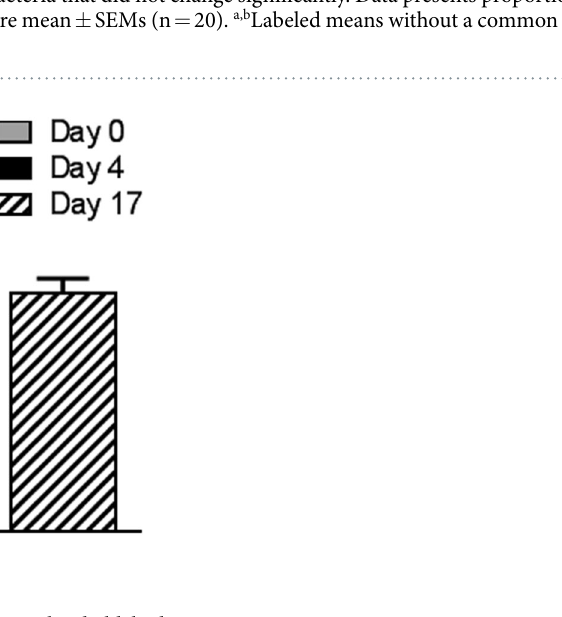
decrease in body weight (p = 2.0E − 05 ). The observed weight loss remained significant and persisted over the fol- lowing 2 weeks and may be related to changes in the microbiome (p = 0.003). The two most abundant bacterial phyla in humans are Firmicutes (40–60%) and Bacteroidetes (20–40%) 10 . Relative proportional abundance of Firmicutes has been associated with increased body weight and that of Bacteroidetes with low body weight. The 3-day juice based diet of only drinking 6 bottles of fruit/vegetable juice blends induced significant changes in the intestinal microbiota. The proportional abundance of the phylum Firmicutes was significantly decreased, while Bacteroidetes was significantly increased when comparing end of juice based diet (day 4) to baseline (Table 1). Human Bacteroides species are able to degrade diverse plant fiber and complex polysaccharides, including pectin and xylans from fruit and vegetable 16, 17 . Bacteroides ovatus, B. thetaio- taomicron and B. uniformis ferment a particularly wide range of complex polysaccharides 16 . In the present study eight Bacteroides species were significantly increased after the juice based diet. A significant increase in the pro- portion of these Bacteroides species ( B. ovatus, B. acidifaciens and B. xylanisolvens ) was also observed in another human intervention study in individuals with metabolic syndrome who included the prebiotic resistant starch in their diet 18 . In that study the increase in Bacteroides was associated with a decrease in markers of metabolic